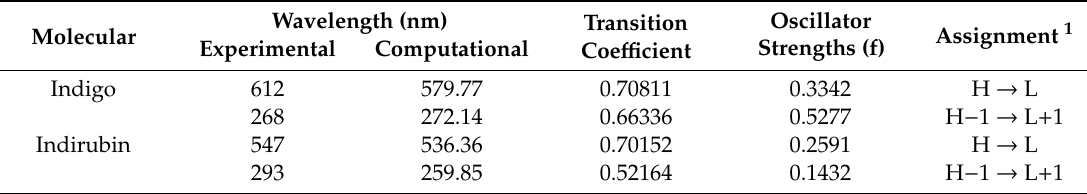
Figure 6. UV-Visible absorption spectra of indigo ( a ) and indirubin ( b ). Table 4. Theoretical UV-Visible absorption spectra of indigo and indirubin computational at B3LYP/6-311G(d,p) level of theory.